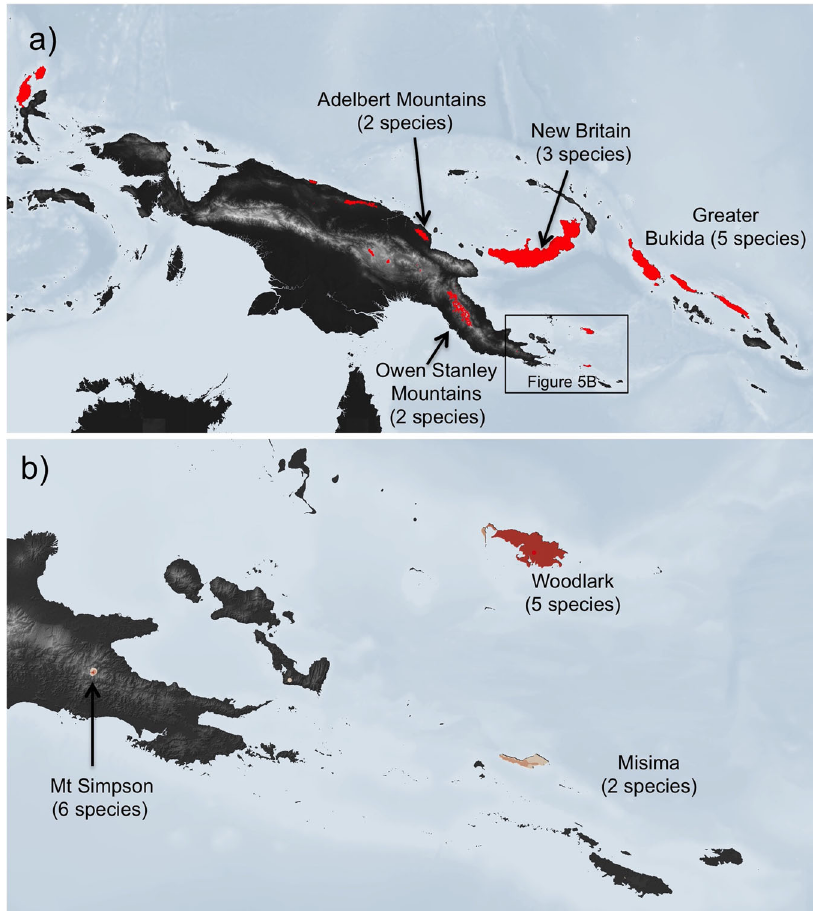
Fig. 5 The distribution of threatened frogs in Melanesia. a The estimated distribution of all 31 Melanesian frog species considered Critically Endangered, Endangered or Vulnerable at the end of 2019. Distributional areas are not colour coded by the number of threatened taxa. b Close up of the Milne Bay endemism hotspot. Distributional areas are colour coded by number of taxa, with darker tones indicating more taxa. In both a and b upland areas or islands where the distributions of two or more threatened species overlap are labelled and the number of threatened taxa are indicated in parentheses. Background maps uses the Shuttle Radar Topography Mission (SRTM) 30-meter digital elevation model, accessed from USGS Earth Explorer